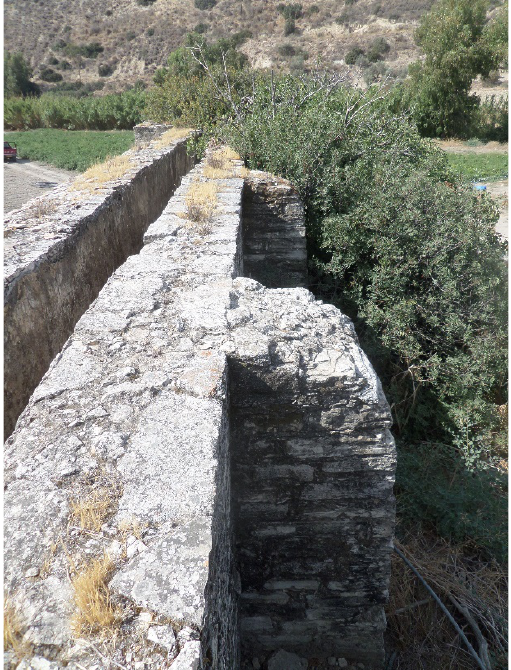
Figure 29. A Late Ottoman watermill outside the present-day village of Alaminos in the Xeros River valley (Image by Athanasios K. Vionis).